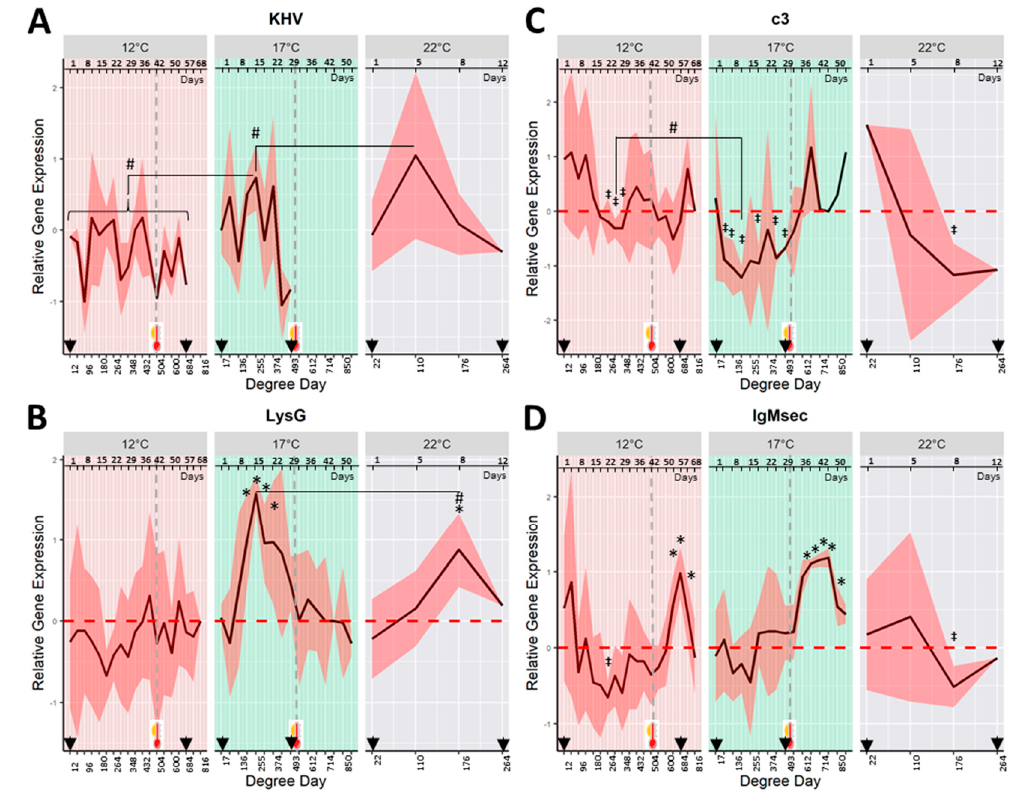
Figure 3. Mean (continuous black line) of the relative gene expression (fold change) over time in common carp skin swabs exposed to koi herpesvirus (KHV). Sampling days expressed as degree days (DD) to compare groups at di ff erent temperatures (12, 17, and 22 ◦ C). A continuous line was used instead of columns to show gene expression patterns over time. Shadow represents 95% confidence intervals around the mean. ( A ) mRNA KHV orf90 (viral shedding); ( B ) lysozyme g ( lysG ); ( C ) complement c3-h1 ( c3 ); ( D ) immunoglobulin M heavy chain secretory protein ( IgMsec ). Arrowheads indicate the window of KHV shedding. (*, ‡ ) represents gene expression significantly higher (*) or lower ( ‡ ) from the control group when p ≤ 0.05. (#) Represents significant di ff erences among treatments. The vertical black dotted line and thermometer denote a change in the temperature (increase to 22 ◦ C heat stress) at ~500 DD, which corresponded to 42 and 30 days after the challenge for fish at 12 ◦ C and 17 ◦ C respectively. Note for Figures 3 and 4: The number of fish sampled each day at 12 ◦ C = 12. The number of fish sampled at 17 and 22 ◦ C overtime decreased due to mortalities. At 17 ◦ C, from 17 to 204 DD = 12 fish each sampling day; from 255 to 342 DD = 10 fish; from 342 to 374 DD = 9 fish; from 374 to 442 DD = 8 fish; from 442 to 612 DD = 6; from 612 to 850 DD = 5; from 850 to 918 = 4. At 22 ◦ C, at 22 and 110 DD = 12 fish; at 176 DD = 9 fish; and at 264 DD = 3